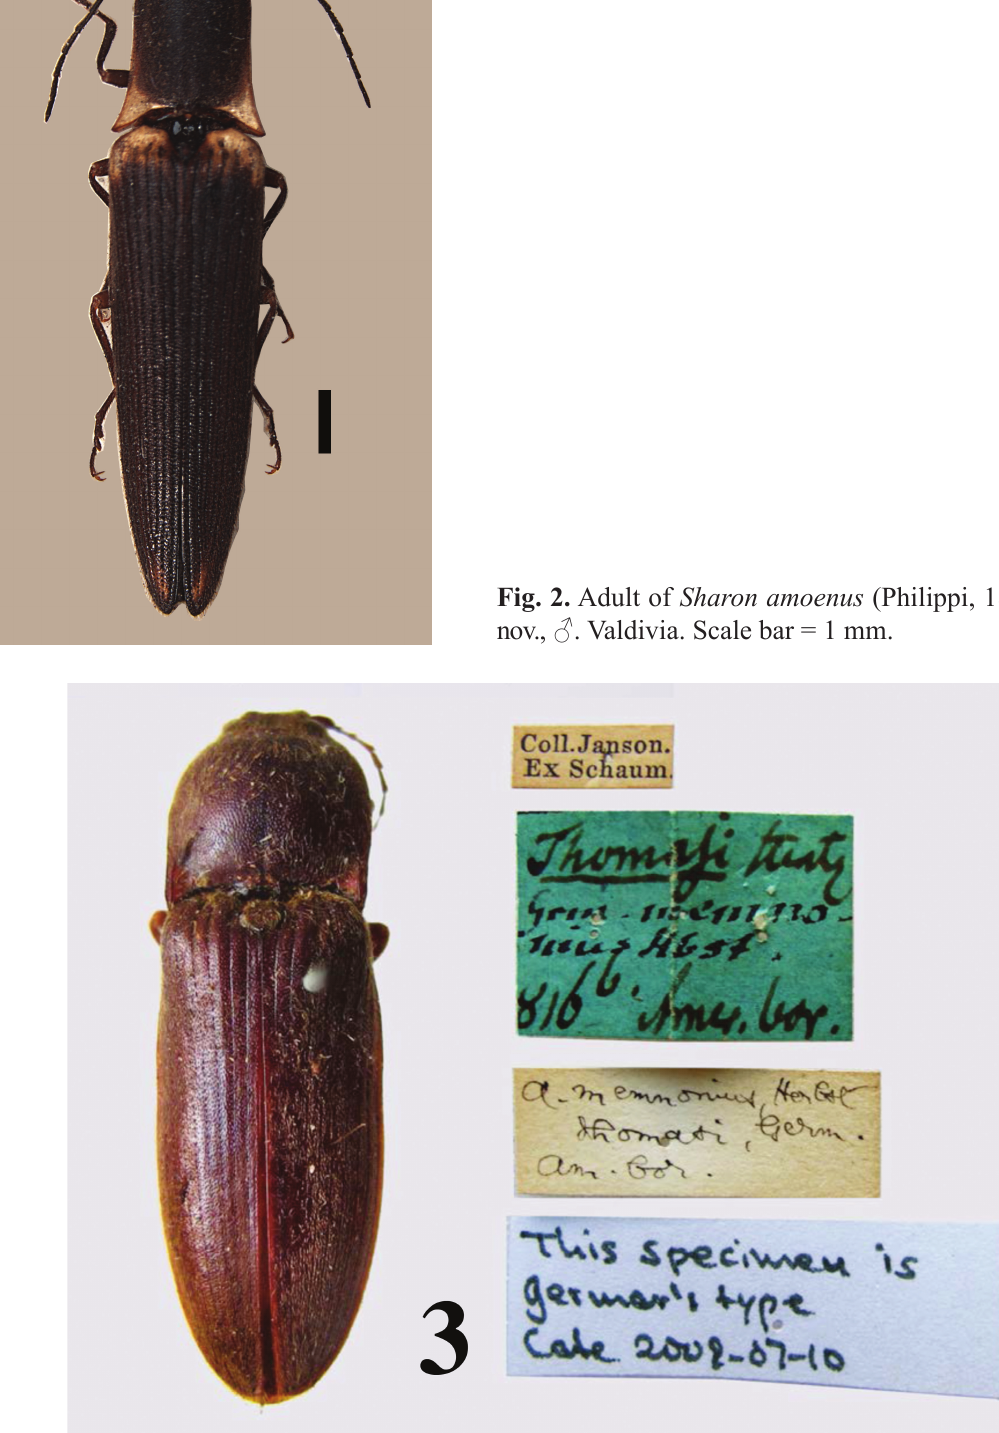
Fig. 3. Adult of Hemicrepidius memnonius herbst, 1806 [= Asaphes thomasi germar, 1839, holotype, approximate body length = 18 mm]. Photo by helena Maratheftis